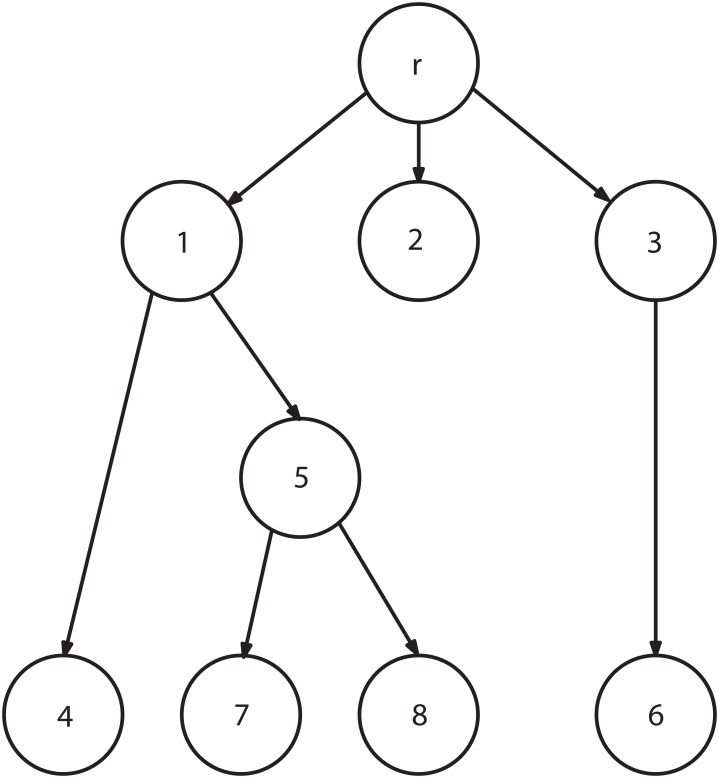
A decision tree.